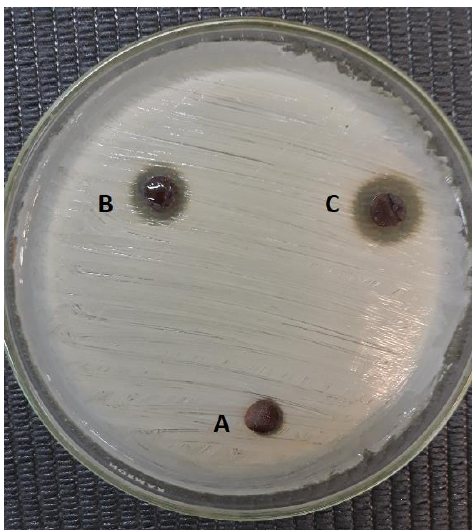
Figure 9. Screening of antibacterial effect of ( A ) PMALH10-AgNPs, ( B ) PMALH20-AgNPs, and ( C ) PMALH30-AgNPs nanohybrids against S. aureus . Table 1. Quantitative assay of antimicrobial activity of PMALH on S. aureus . Assay